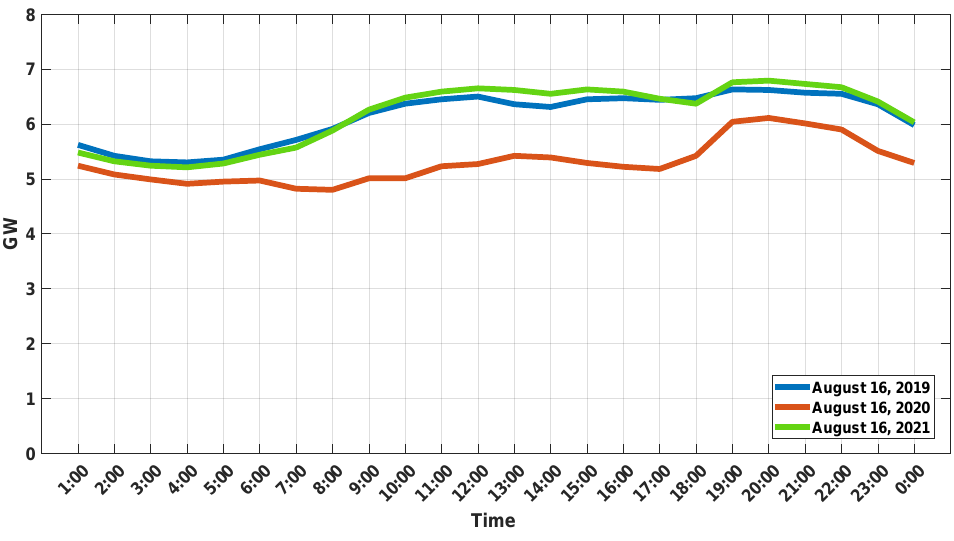
Figure 7. Electrical demands by